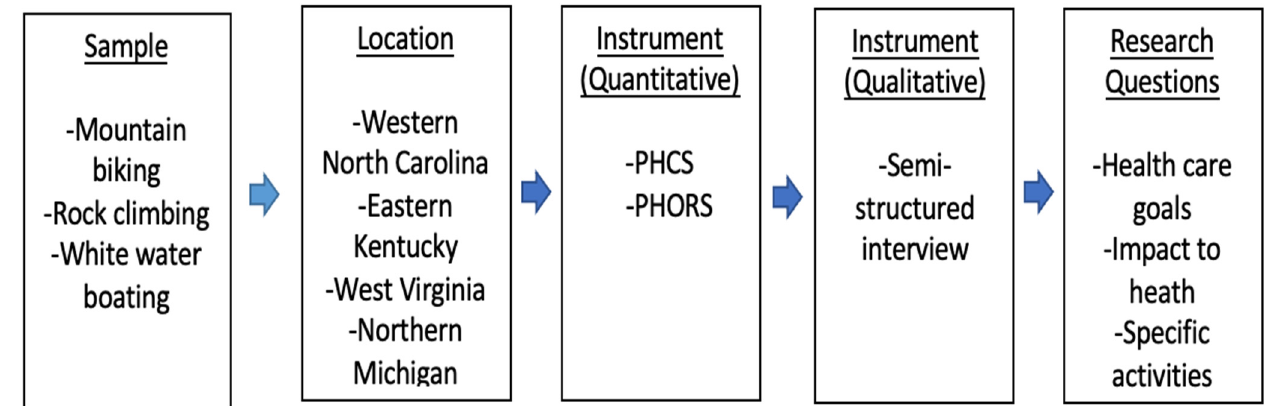
Figure 1. Logic train outline for the study.